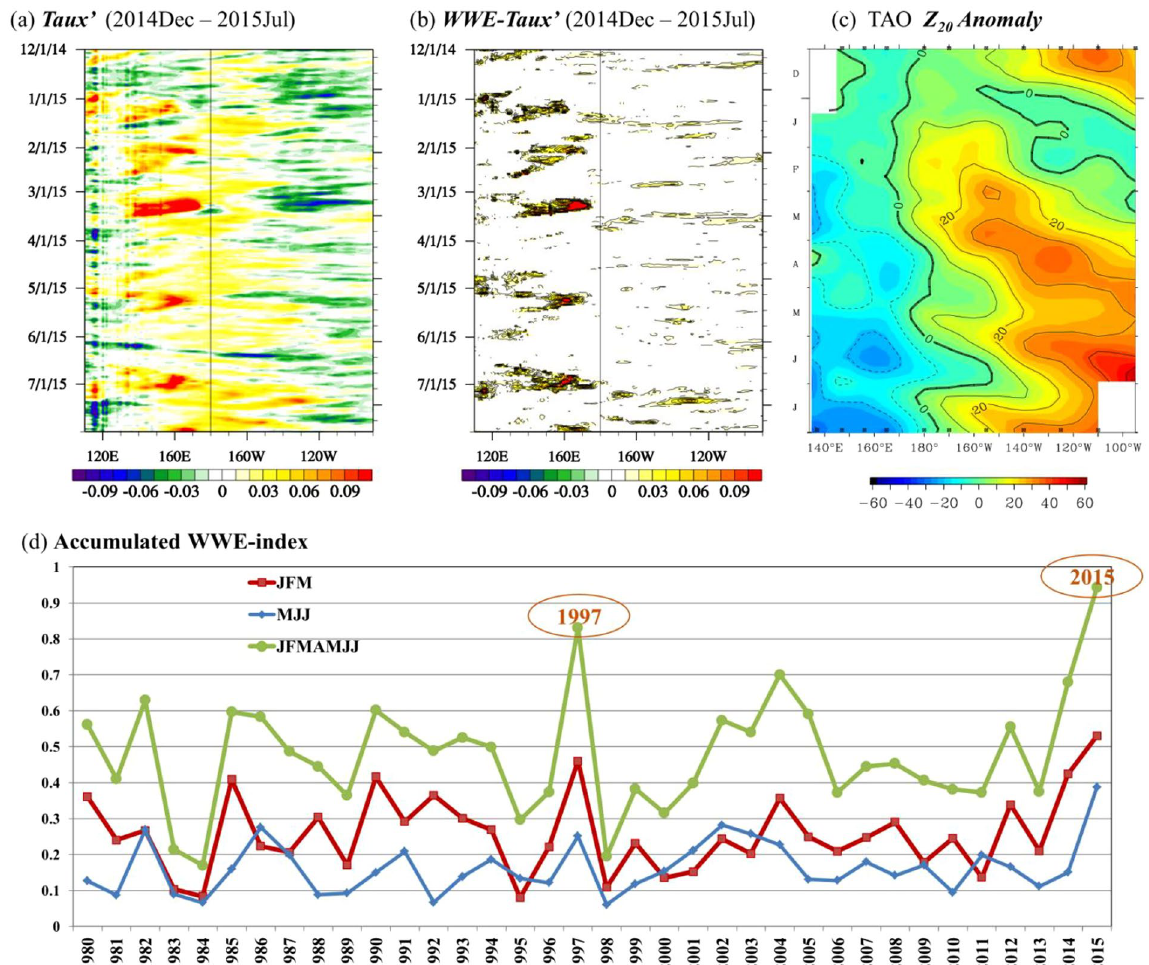
Figure 3. Evolution of ( a ) the zonal wind stress anomaly ( Taux ′ ), ( b ) WWE-Taux ′ , and ( c ) 20 °C isotherm depth anomaly along the equator, from Dec 1, 2014 to July 31, 2015. The Taux ′ and WWE-Taux ′ are derived from the zonal wind stress ( Taux ) daily data covering 1979–2015. See the main text for the detailed derivation method. Figure 3c is derived from the TAO/TRITON observation provided by PMEL. ( d ) Time series of the accumulated WWE-index, which is obtained through integrating the WWE-index for the period of January– March (JFM; red curve), May–July (MJJ; blue curve) and January–July (JFMAMJJ; green curve) of each year. The WWE-index in a given day is obtained by integrating the WWE-Taux ′ over WWE region (see detailed description in Method). Figure 3a,b,c were generated by the NCAR Command Language (NCL, version 6.2.1, [Software]. (2014). Boulder, Colorado: UCAR/NCAR/CISL/VETS. http://dx.doi.org/10.5065/D6WD3XH5), and Fig. 3d was generated by the licensed Microsoft